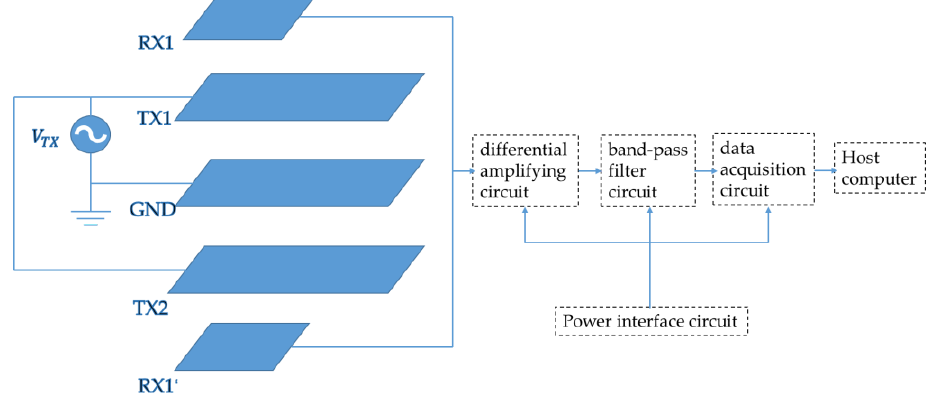
Figure 7. Structure and signal-processing circuit design of the detection system. The signal-processing circuit includes a differential amplifying circuit, a band-pass filter circuit, a data acquisition circuit, and a power interface circuit.